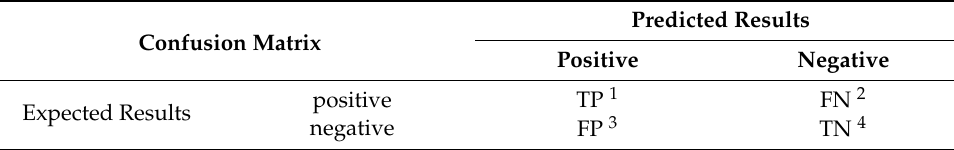
Table 2. Parameter Table 2. Parameter definitions.